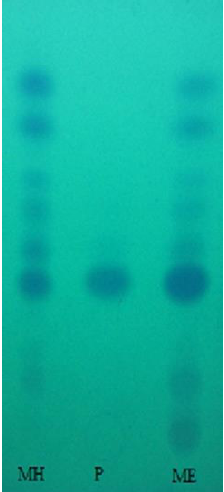
Figure 1. TLC profile of white pepper